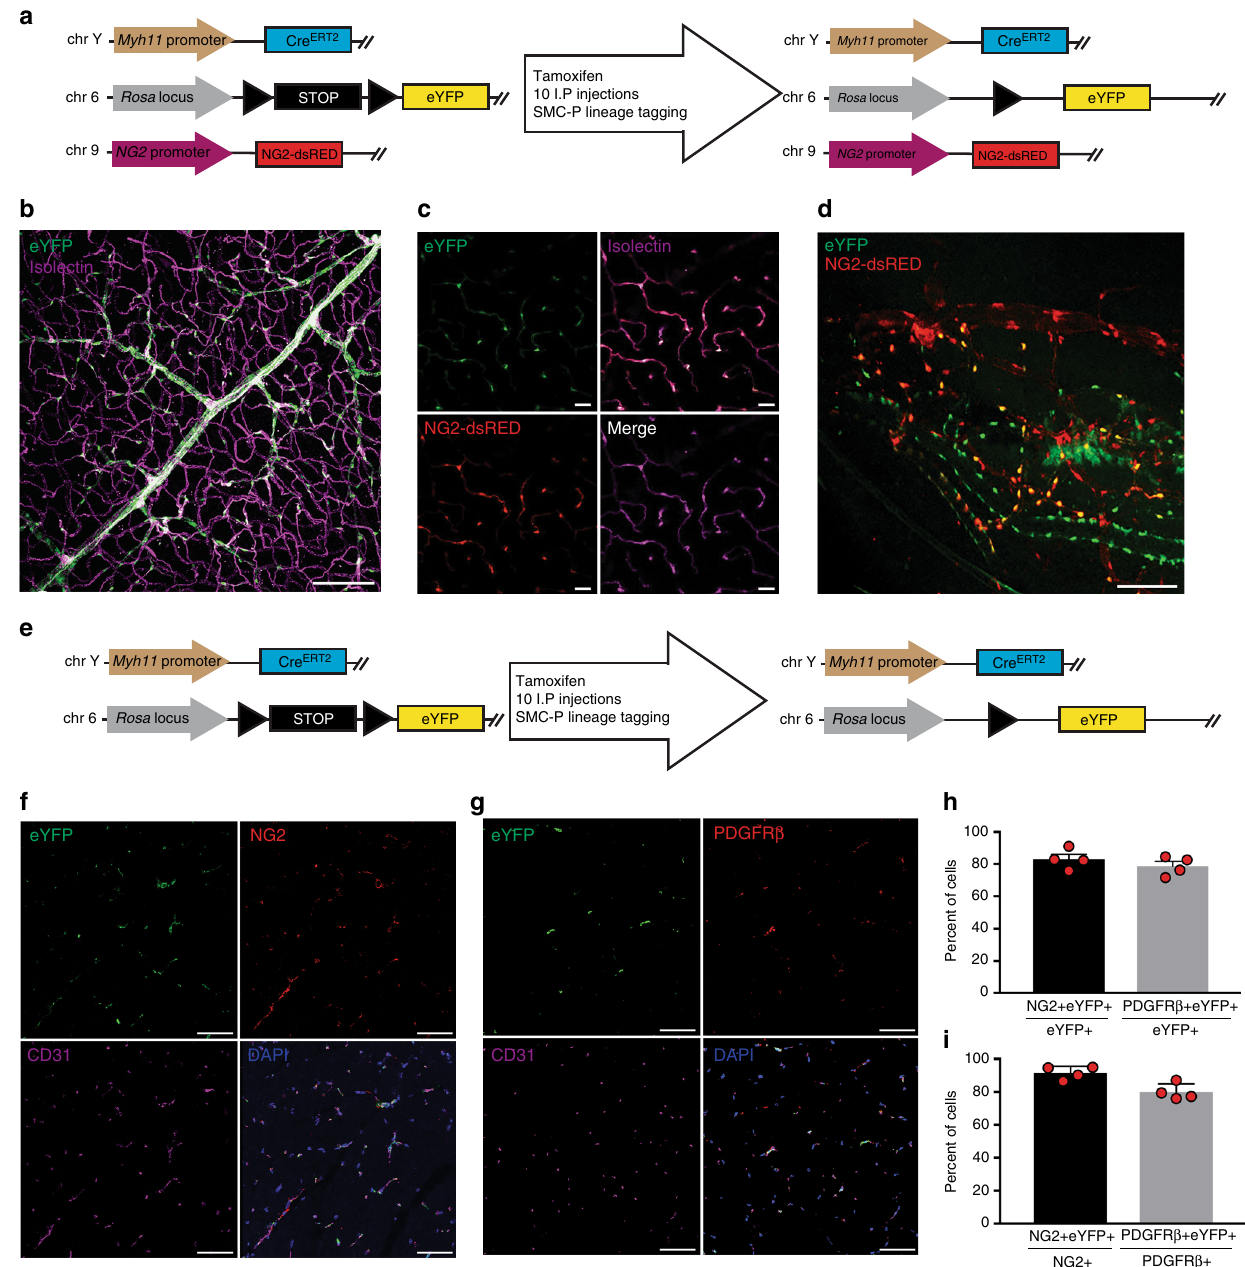
Fig. 1 Myh11-CreER T2 ROSA eYFP ef fi ciently labeled SMC and a large subset of pericytes in multiple microvascular tissue beds. a Schematic showing crossing of Myh11-CreER T2 ROSA fl oxed STOP eYFP mice with NG2-DsRED mice plus tamoxifen injection to generate NG2-DsRED Myh11-CreER T2 ROSA eYFP mice. b and c Imaging of retina whole mounts for eYFP, NG2-DsRED, and isolectin. Scale bar in b = 100 μ m. Scale bars in c = 20 μ m. d Intravital microscopy of cornea limbal vasculature for eYFP and NG2-DsRED. Scale bar = 50 μ m. e Schematic showing Myh11-CreER T2 ROSA eYFP mice. f and g Co- staining of uninjured calf muscle cross sections from Oct4 SMC-P WT/WT mice for DAPI, eYFP, and NG2 ( f ) or PDGFR- β ( g ). Scale bars = 50 μ m. h and i Quanti fi cation of percentages of dual positive cells within calf muscle ( n = 4 mice). Values = mean ±